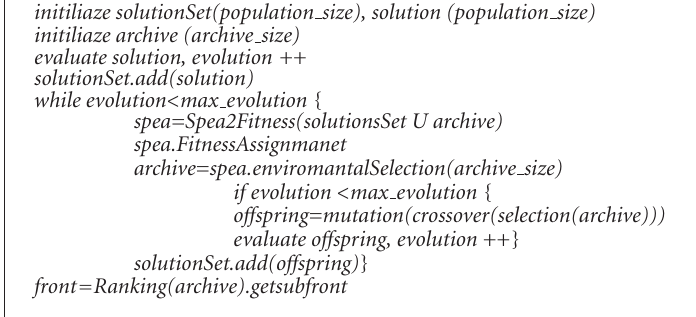
Algorithm 2: A pseudocode for SPEA II procedure.